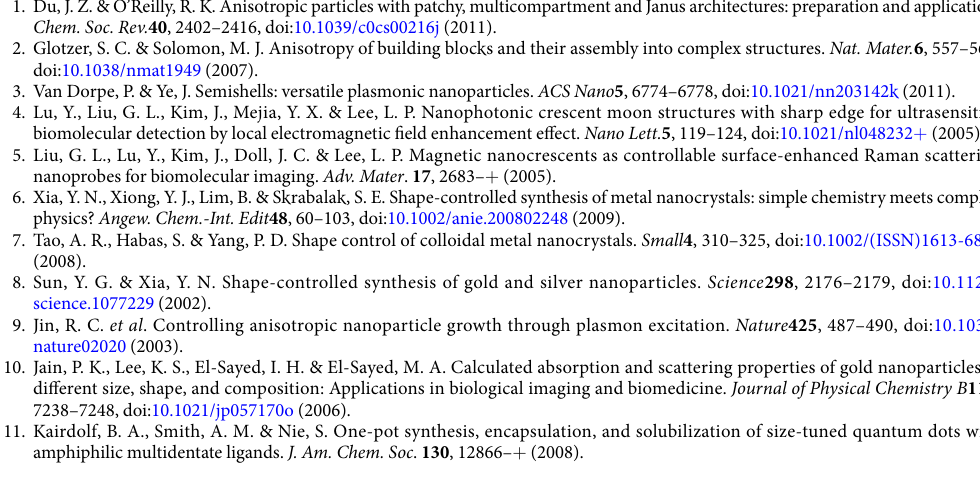
4 Scientific RepoRts | 7: 2921 | DOI:10.1038/s41598-017-02485-7